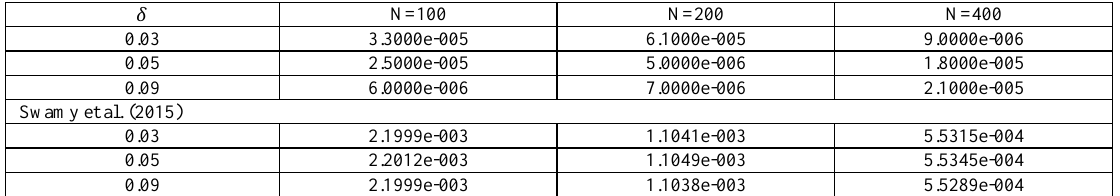
Table 3. The maximum error obtained for 𝛆 =0.1 for different values of N and 𝛅 for Example 2 𝛿 N=100 N=200 N=400